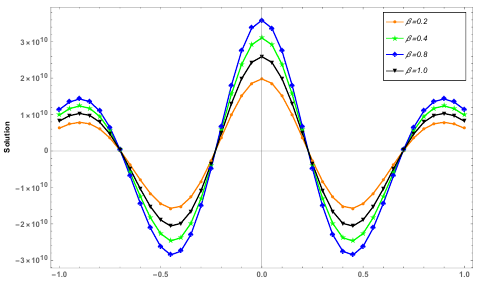
Figure 11. 2D surface formation at different values of β in Example 4 when λ = 1, w = 1, ρ = 2.5, µ = 1 and t =